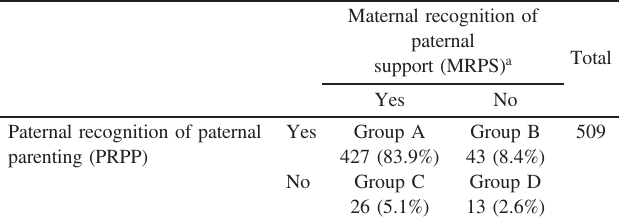
Table 2. Distribution of parental recognition of paternal parenting and support